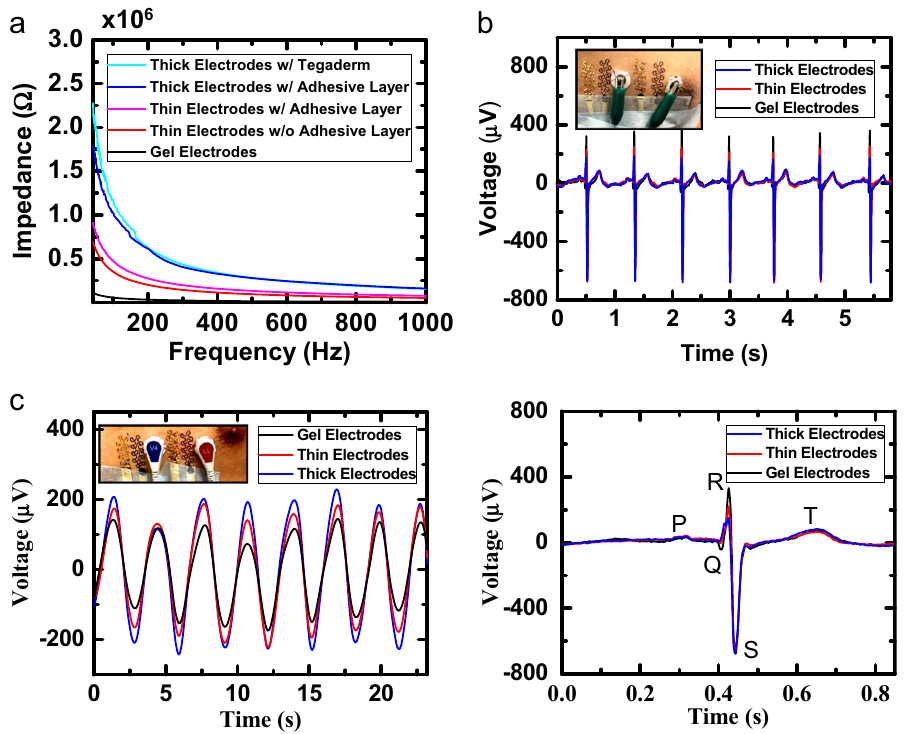
Fig. 3 Characterization of ECG tattoo sensor. a Skin-electrode interface impedance measured for 13- μ m-thick e-tattoo with Tegaderm tape (cyan) and skin adhesive (blue), 1.5- μ m-thick e-tattoo with (magenta) and without (red) skin adhesive, and gel electrodes (black). b Upper panel: ECG signals synchronously captured by 13- μ m-thick e-tattoo (blue), 1.5- μ m-thick e-tattoo (red), and gel electrodes (black). Lower panel: zoomed-in ECG signal with characteristic peaks labeled. c Respiration rate captured by 13- μ m-thick e-tattoo (blue), 1.5- μ m-thick e-tattoo (red), and gel electrodes